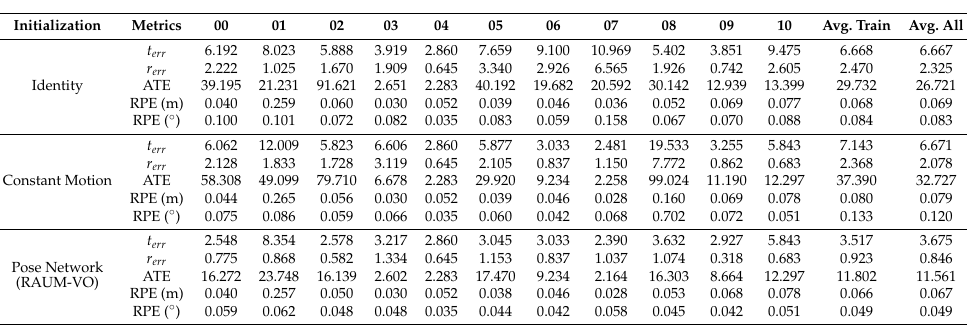
Table 3. F2F solver initialization. Comparison of different initialization approaches for the Levenberg– Marquardt scheme that solves the frame-to-frame motion. Overall, the rotation from the pose network is the best, followed by a constant motion model.